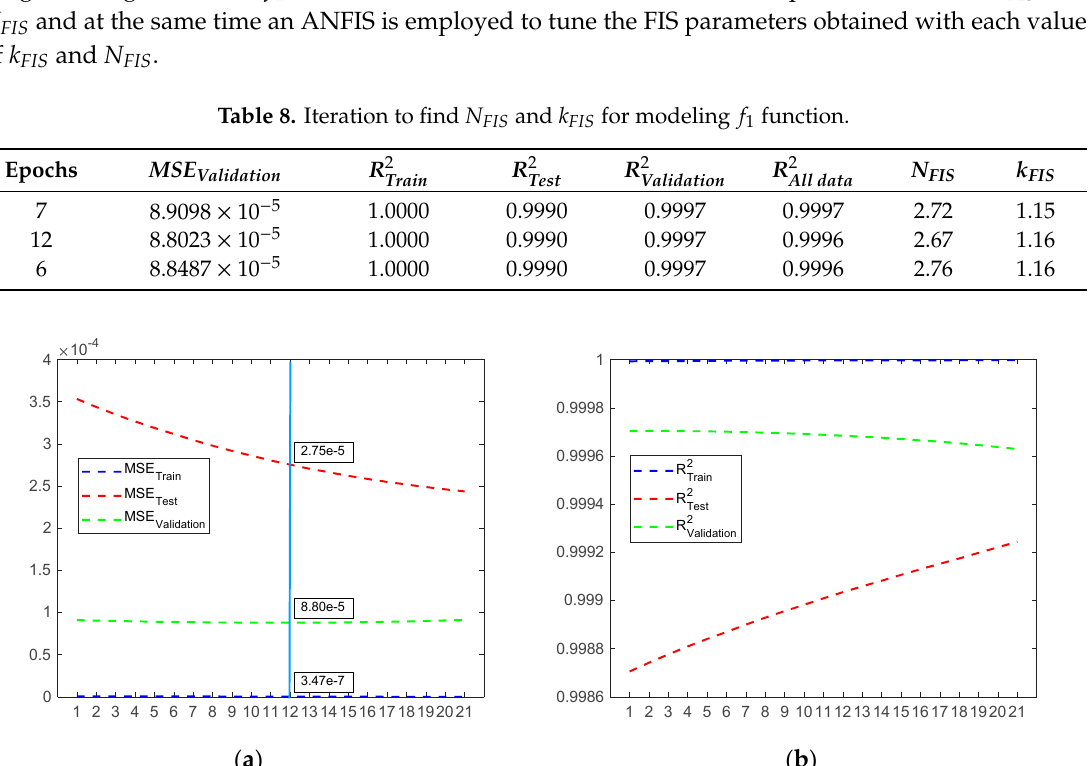
Figure 26. Best MSE and obtained squared-R (Number of Epochs = 10, 𝑘 (cid:3007)(cid:3010)(cid:3020) = 1.16 , 𝑁 (cid:3007)(cid:3010)(cid:3020) = 2.67 ). Table 8. Iteration to find 𝑁 (cid:3007)(cid:3010)(cid:3020) and 𝑘 (cid:3007)(cid:3010)(cid:3020) for modeling 𝑓 (cid:2869) function.